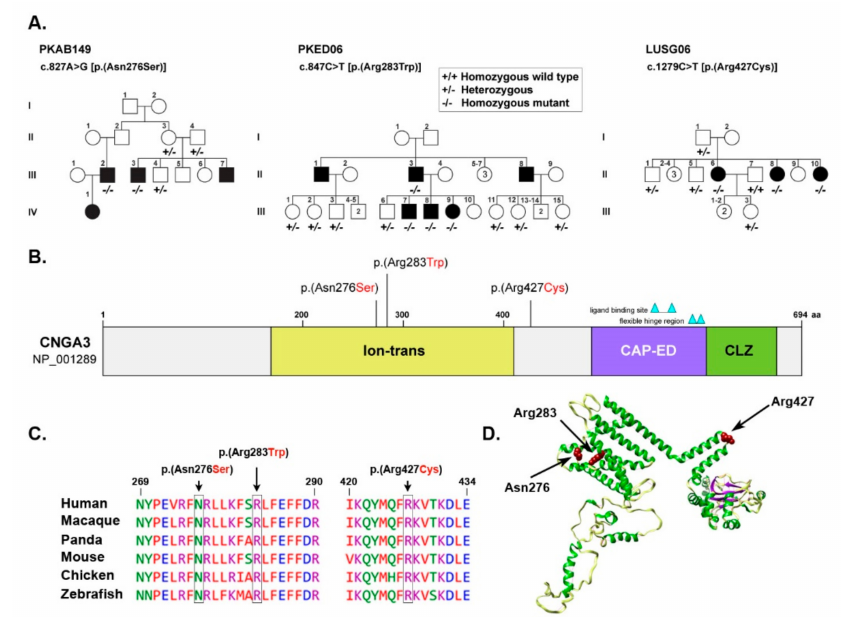
Figure 1. ( A ) Pedigrees of Pakistani families segregating with CNGA3 variants. Filled and empty symbols represent affected and unaffected, respectively. The genotypes are mentioned below